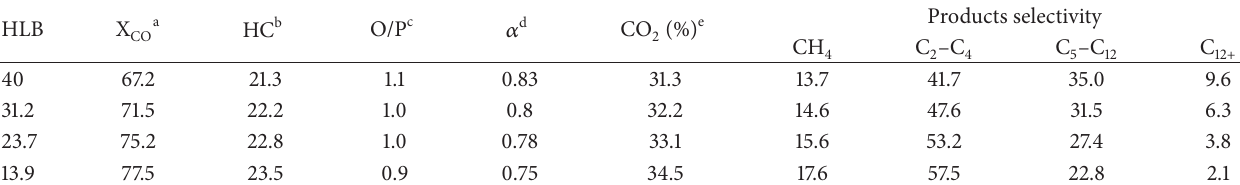
Table 4: Catalysts activity and products selectivity after 35 h time-on-stream.